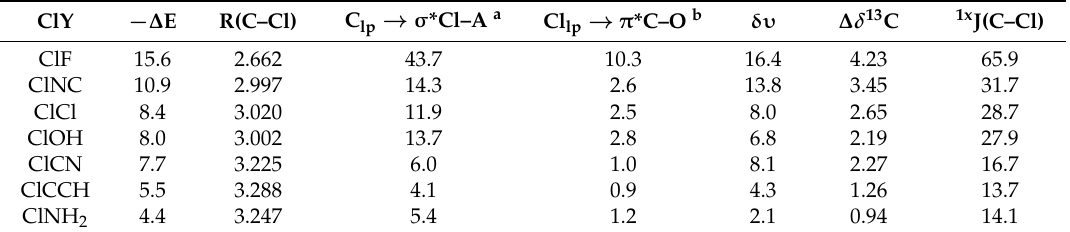
Table 1. Binding energies ( − ∆ E) and charge-transfer energies (C lp → σ *Cl–A and Cl lp → π